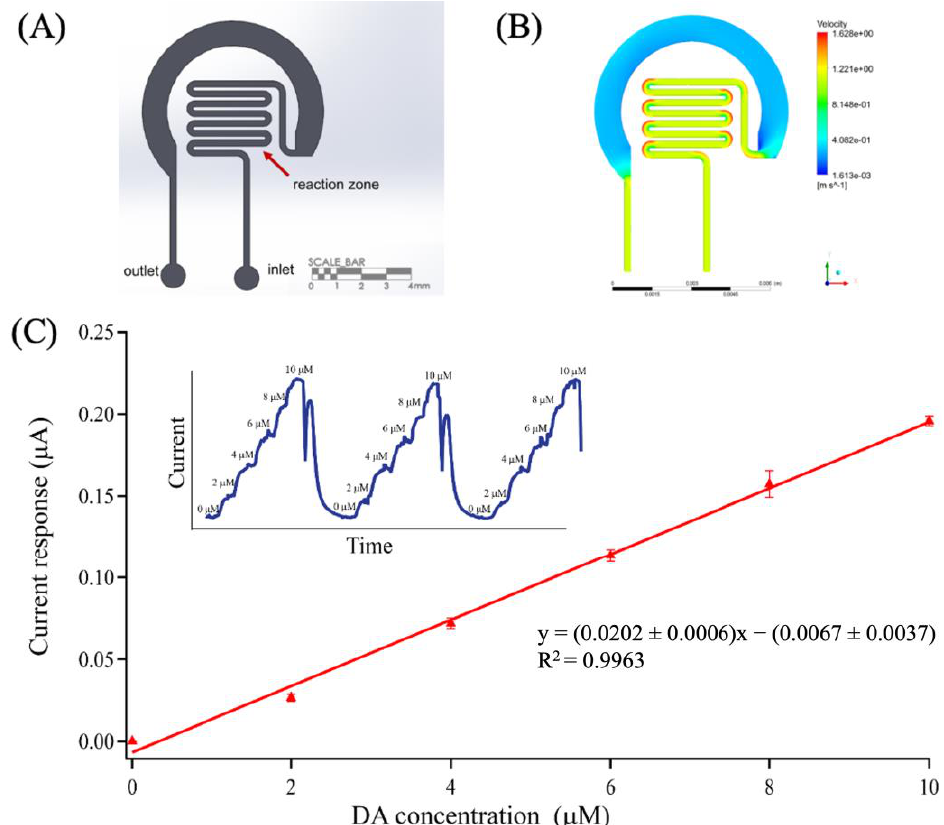
Figure 6. ( A ) Design of a serpentine microfluidic channel used for integrating on OMC-PEDOT-PSS/SPCE; showing the position of the inlet, the outlet and the reaction zone. ( B ) Top view: velocity profile of a serpentine microfluidic chip showing flow behaviors in serpentine microfluidic chip, using ANSYS Fluent CFX. ( C ) Calibration plot obtained using an autocalibration microfluidic sensor platform. The inset showed an example of continuous calibration for three cycles using 5-point standard addition at a constant 2.0 µ L min − 1 total flow rate. The reduction in the current signal after the auto-calibration is complete flow dopamine from the syringe. The next step is filling the PBS solution in the syringe and flow the PBS solution into the microfluidic channel for access to the base line. However, there are some solutions of dopamine in the tube; thus, the current signal increased and decreased again as the dopamine solution was leached.